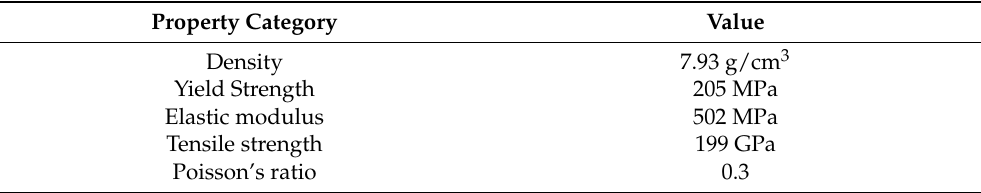
Table 1. The material properties of the structural